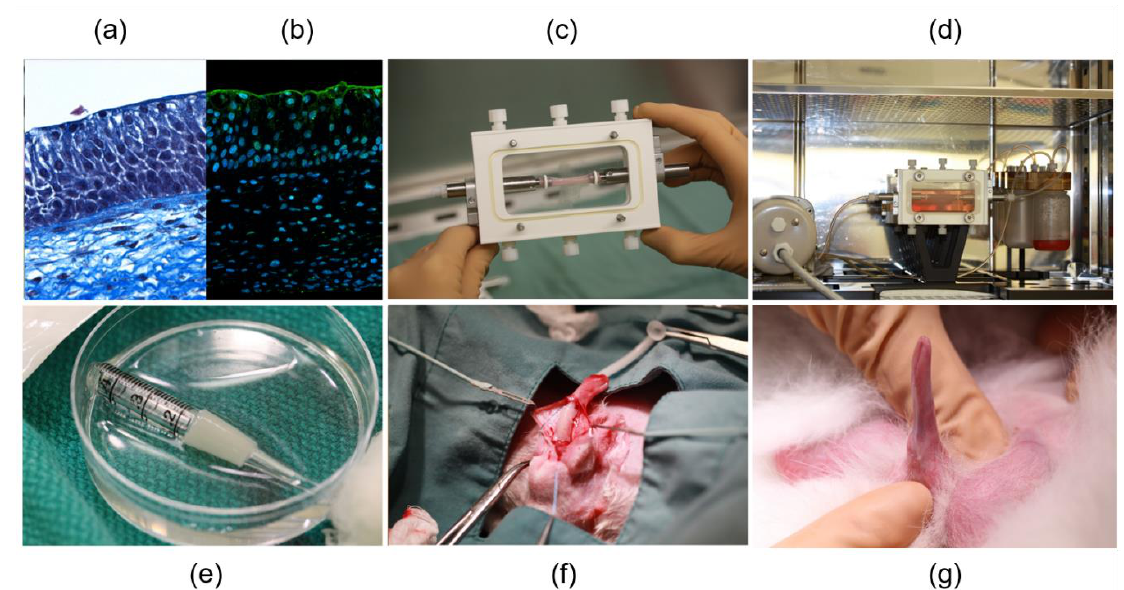
Figure 5. Self-assembly tissue-engineered urethra segment: from the lab to the animal. The upper panels represent successively ( a ) a Masson’s trichrome staining of a slice of TE urethra segment; ( b ) immunofluorescence against uroplakin-2; ( c ) TE tubular urethra in a cassette of the LumGen bioreactor, and finally, ( d ) a TE urethra segment in the bioreactor to simulate urine flow. The lower panels represent the implantation, into rabbits, of a 1.5cm segment of TE urethra produced by the self-assembly method after maturation in the LumGen bioreactor. This segment was reconstructed without epithelium to avoid an immune reaction. The rabbit epithelium can recolonize short segments after grafting; the first panel ( e ) shows the TE urethra segment; the second panel ( f ), the implantation of the TE urethra graft to replace a portion of the rabbit’s urethra; and finally, the third ( g ), the erection test on rabbit penis after the implantation of the TE urethra segment produced by the self-assembly method [236].